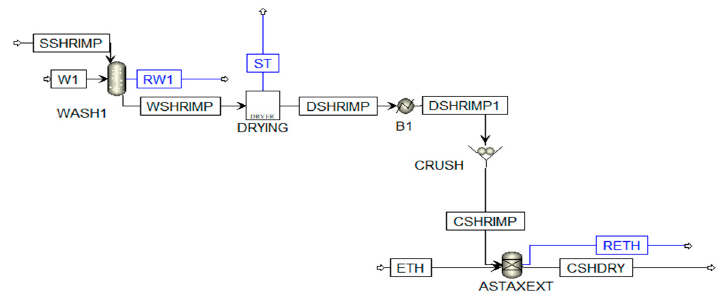
Figure 3. Shell waste pretreatment. Adapted from Meramo-Hurtado et al. [28].